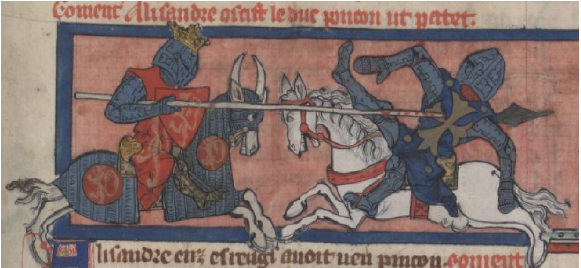
Figure 16. Miniature from the Roman de toute chevalerie by Thomas de Kent depicting Alexander the Great.